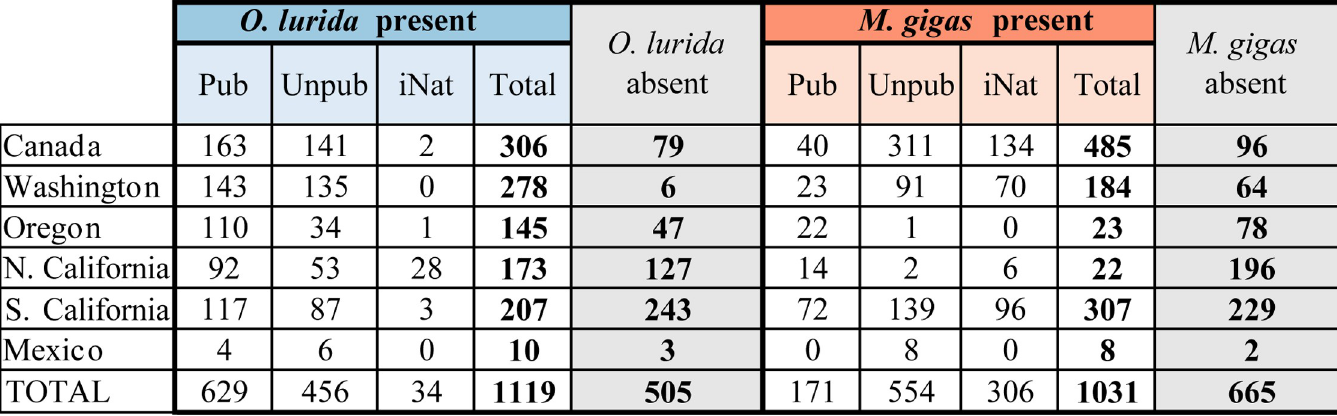
PLOS ONE | https://doi.org/10.1371/journal.pone.0263998 March 17,